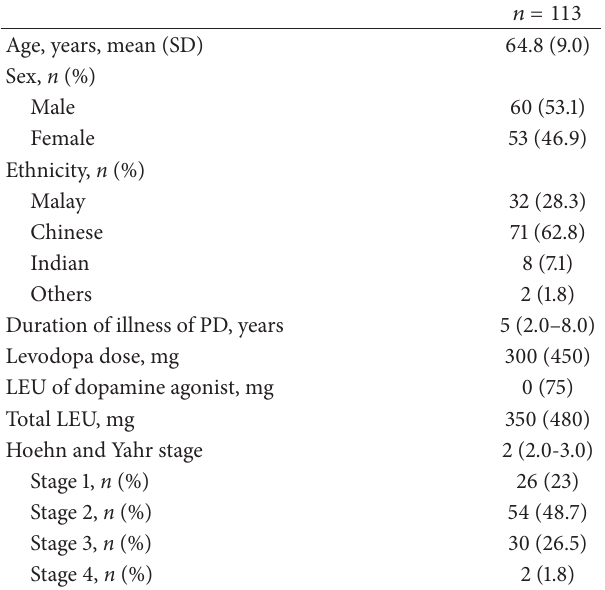
Table 1: Baseline characteristics of study